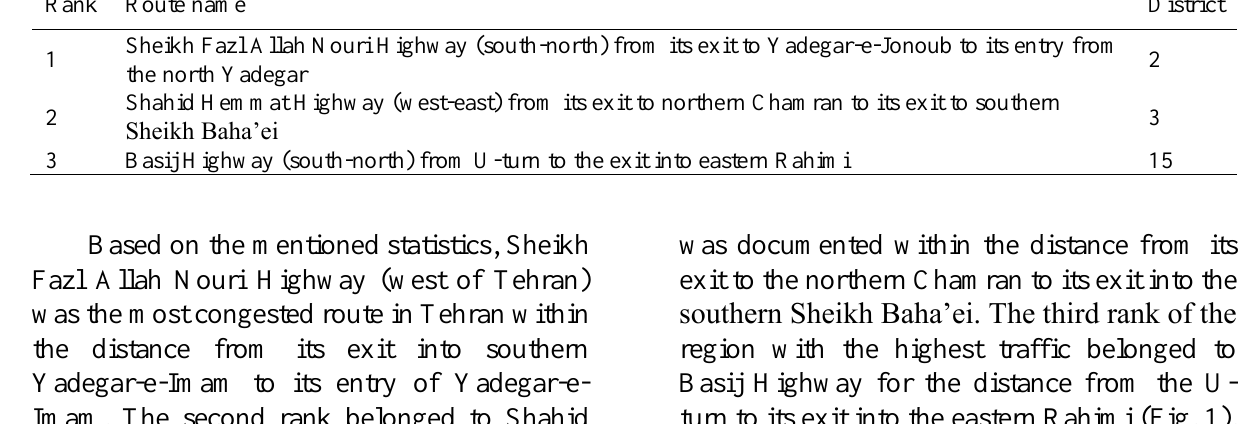
Table1. First three ranks of districts with highest traffic in metropolitan Tehran Rank